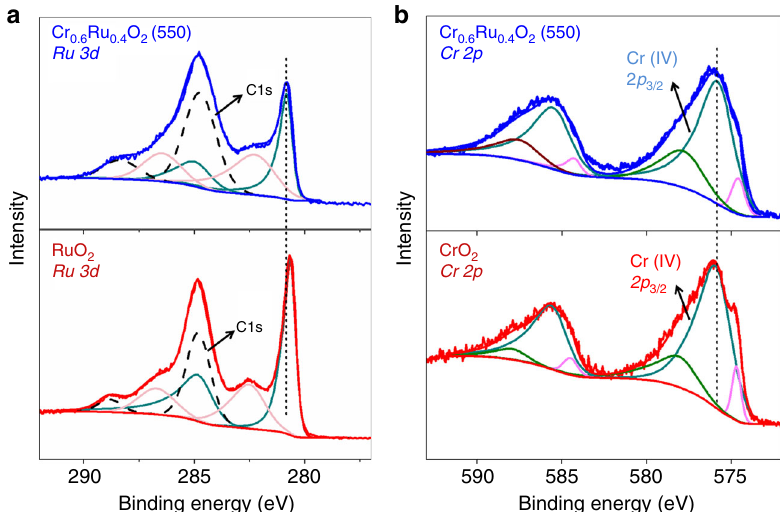
Fig. 6 XPS of Cr 0.6 Ru 0.4 O 2 (550) for Ru 3 d and Cr 2 p . a XPS of Cr 0.6 Ru 0.4 O 2 (550) and RuO 2 for Ru 3 d regions. b XPS of Cr 0.6 Ru 0.4 O 2 (550) and CrO 2 for Cr 2 p regions. The blue and red smoothing lines are fi tting results of the sum of individual components. For Ru 3 d , color codes are used to distinguish the different spin-orbit components, dark cyan for primary Ru 3 d 3/2 and 3 d 5/2 spin states, and light magenta for satellite Ru 3 d 3/2 and 3 d 5/2 spin states